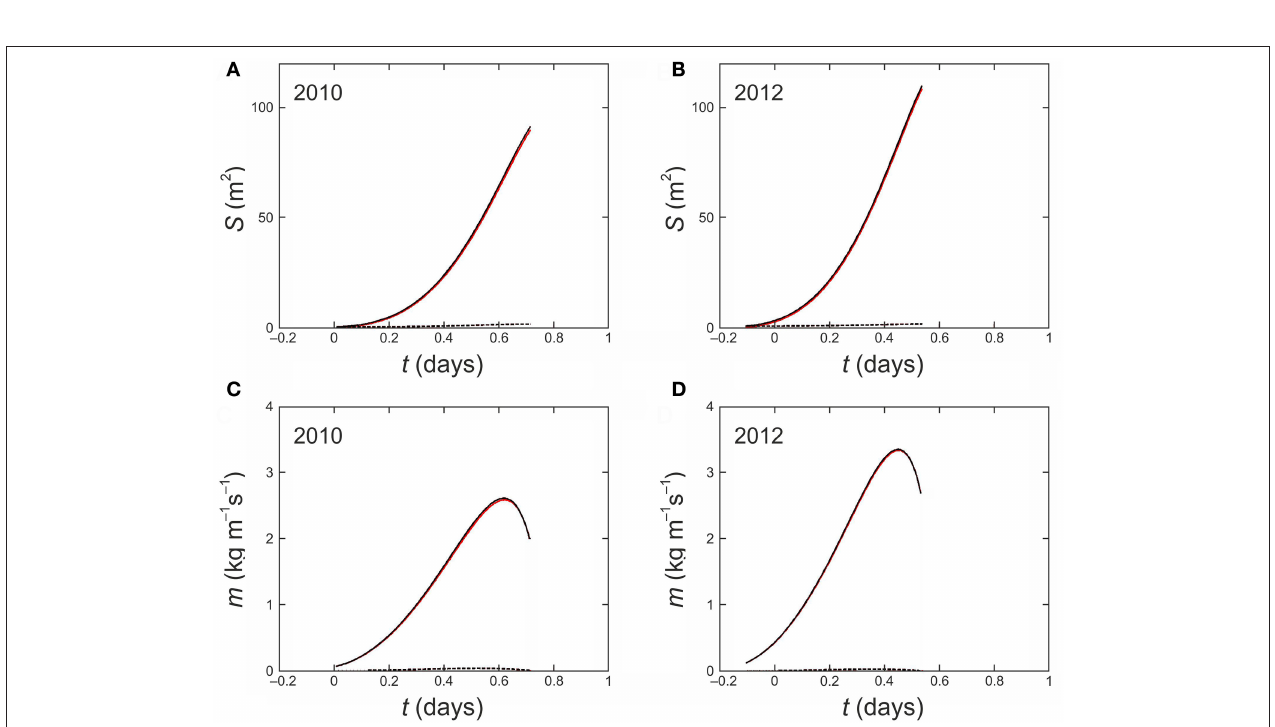
FIGURE 6 | Numerical sensitivity experiments showing the effect of altering individual parameters on the 2010 flood hydrograph, using the optimal model run for l c 500m as control. Parameters are: (A) Lake water temperature T L ; (B) highstand lake level h HS ; (C) Manning roughness n’ ; (D) conduit length l c ; (E) lake inflow rate Q IN . Results for l c 700m and for 2012 are qualitatively similar. =